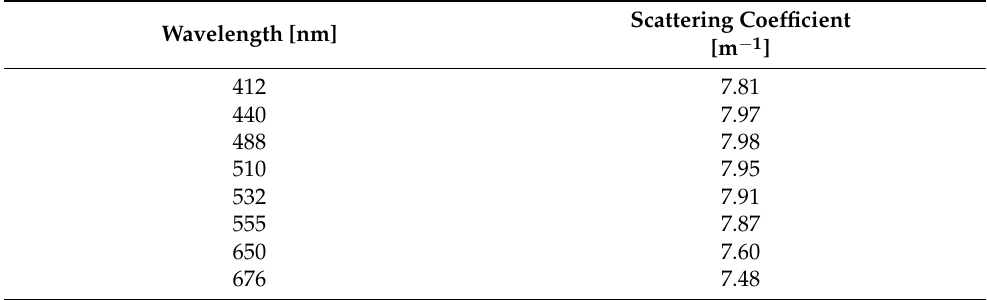
Table 4. The scattering coefficient of an oil-in-water emulsion with a concentration of 10 ppm used in the sea environment optical model [26].